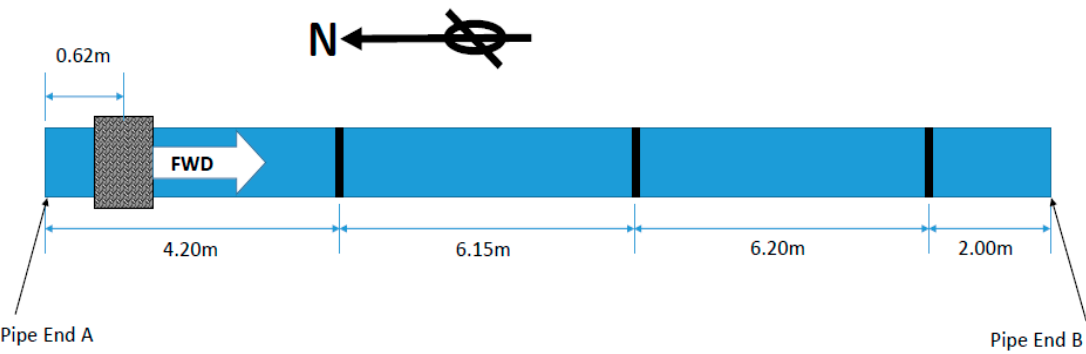
Figure 4. Experimental setup of Pipe A. The tool position is 0.62 m from the end of Pipe A and the welds are illustrated as black lines.